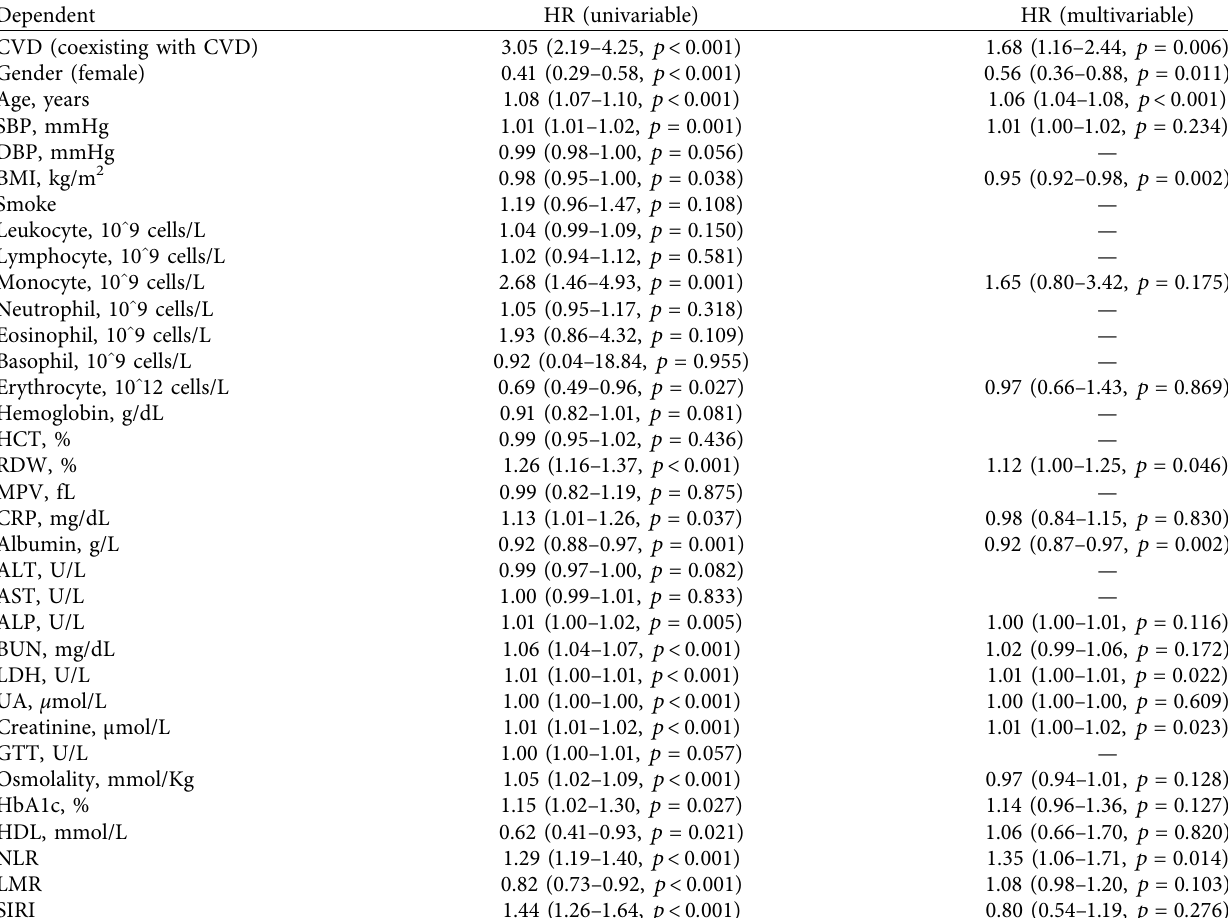
Table 4: Univariate and multivariate COX regression analysis for predicting long-term mortality in